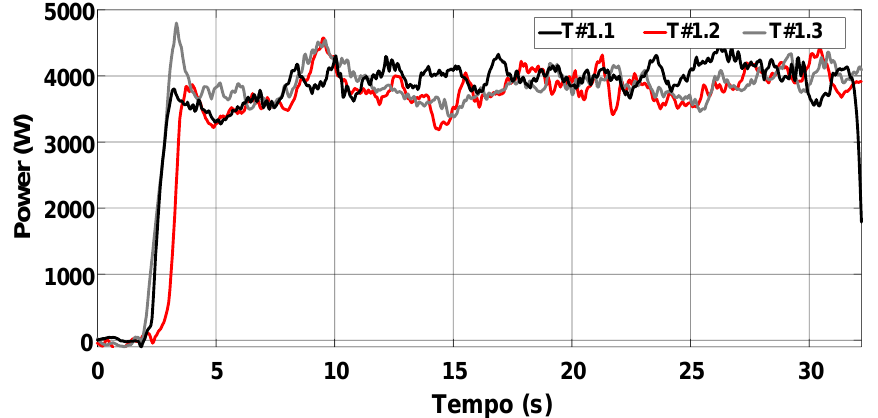
Figure 18. Power consumption during the trial sessions carried out on firm soil and without slip control.